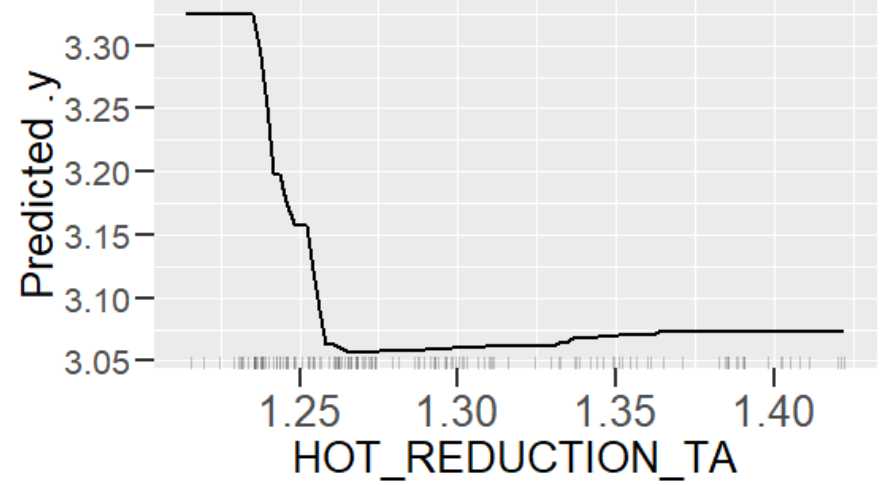
Figure 12. PDP of the reduction of the steel strip at the first tandem pass.